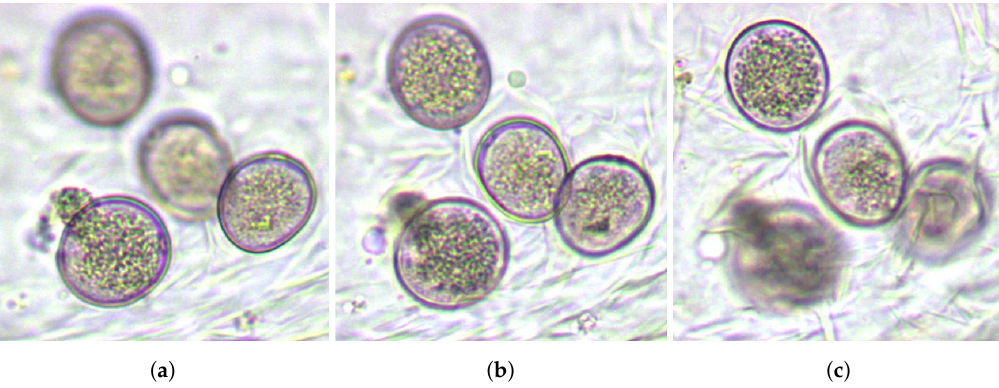
Figure 1. Different focal planes of the same area of a sample. It can be observed how the selected focal plane significantly influences the identification of grain-type objects: ( a , c ) show highly unfocused grains, while ( b ) allows the four grains to be